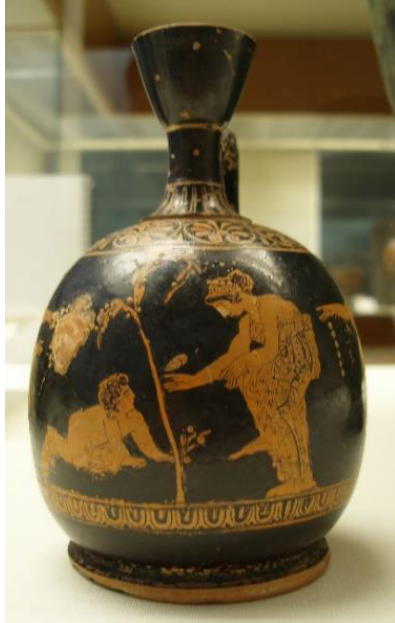
Figure 13. Chart illustrating relative numbers of scenes featuring women and children and those featuring only children, including all known provenances. Data from the BAPD. Chart created by author.